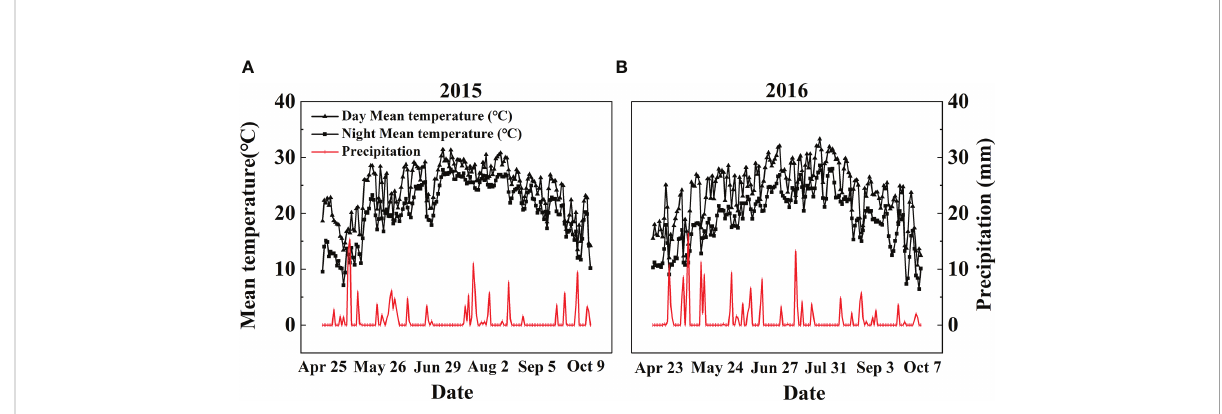
FIGURE 1 Daily precipitation and day/night mean temperatures during the (A) 2015 and (B) 2016 peanut-growing seasons in Shenyang, Northeast